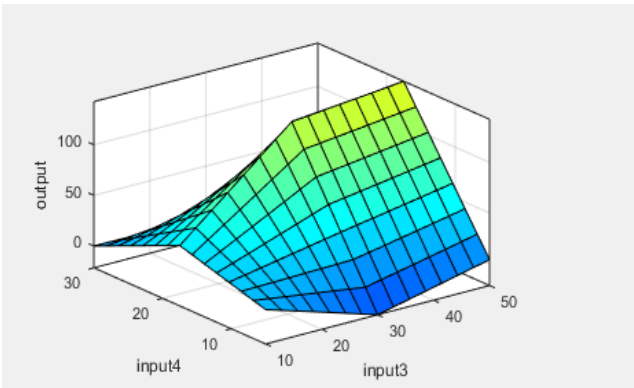
Figure 15. Surfview of output